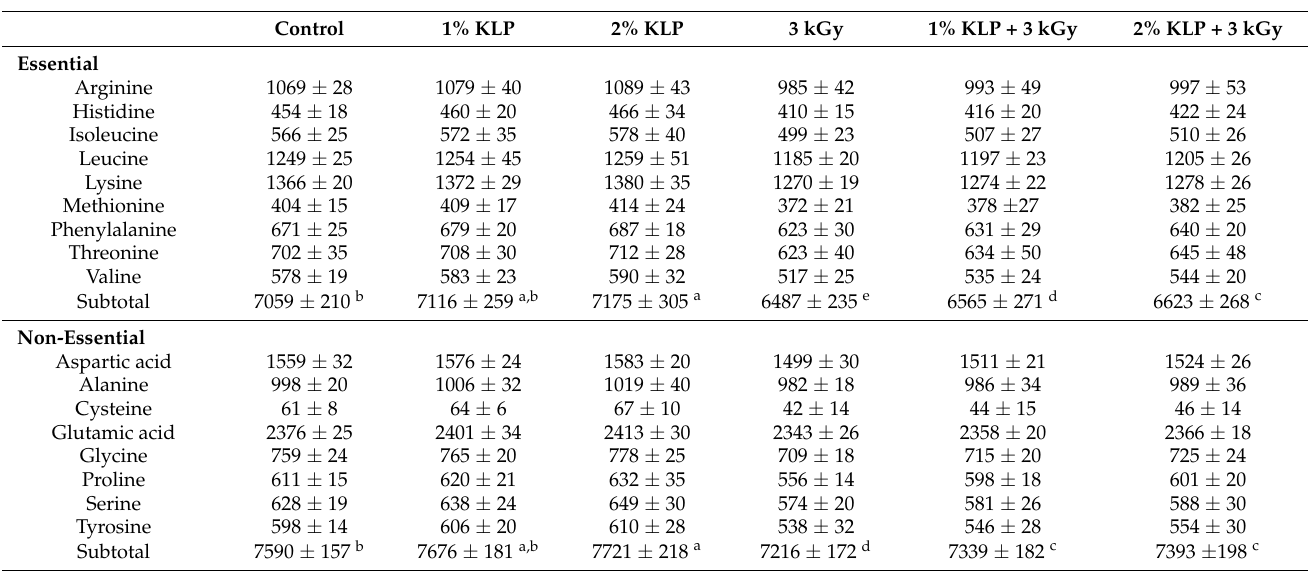
KLP: Kale leaf powder. The values are mean ± SD of three independent determinations; means with different